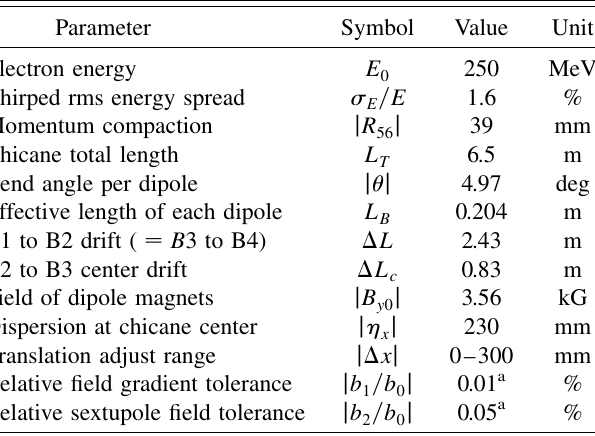
TABLE IV. Nominal BC1 compressor chicane parameters.